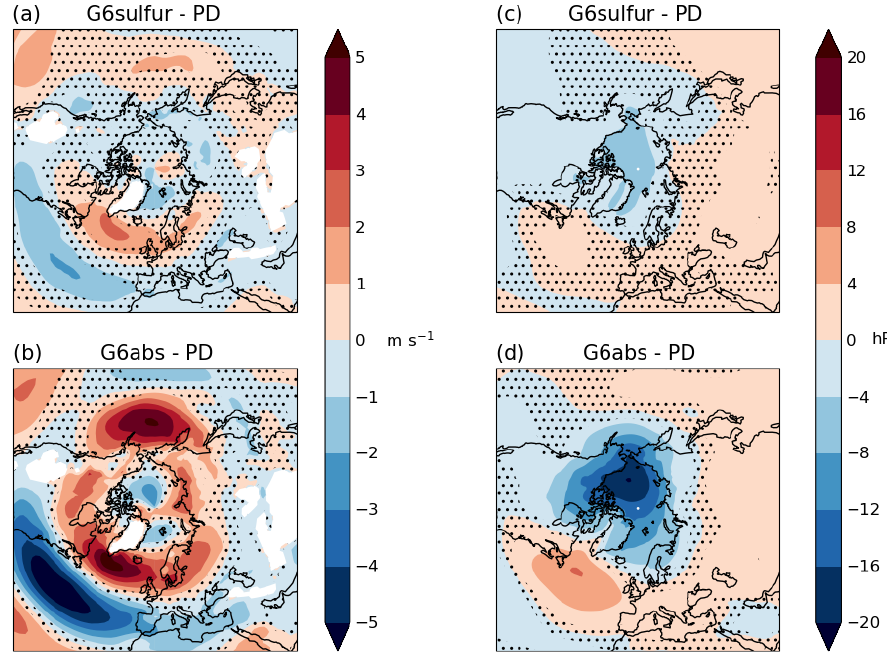
Figure 8. Panels (a) – (b) show the spatial distribution (2081–2100 compared to PD) of the perturbation to the 850hPa wind speed for DJF for (a) G6sulfur and (b) G6abs. White areas represent elevated areas where the surface pressure is less than 850hPa. Panels (c) – (d) show the spatial distribution of the perturbation (2081–2100 vs. PD) to mean sea-level pressure (MSLP, hPa) for (c) G6sulfur and (d) G6abs. Stippling represents areas that are not significant at the 5% level using a two-tailed t -test.